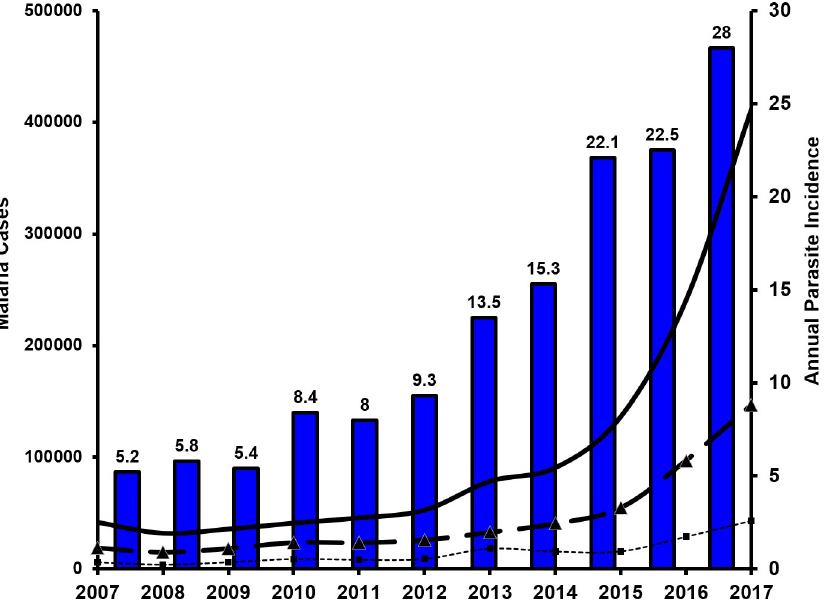
Fig 2. Number of confirmed malaria cases in Venezuela (solid line) and Bolı´var state (dashed line: P . vivax and small dashed line: P . falciparum ). Annual parasite incidence (API: Number of confirmed malaria cases/1,000 inhabitants, blue bars) in Venezuela